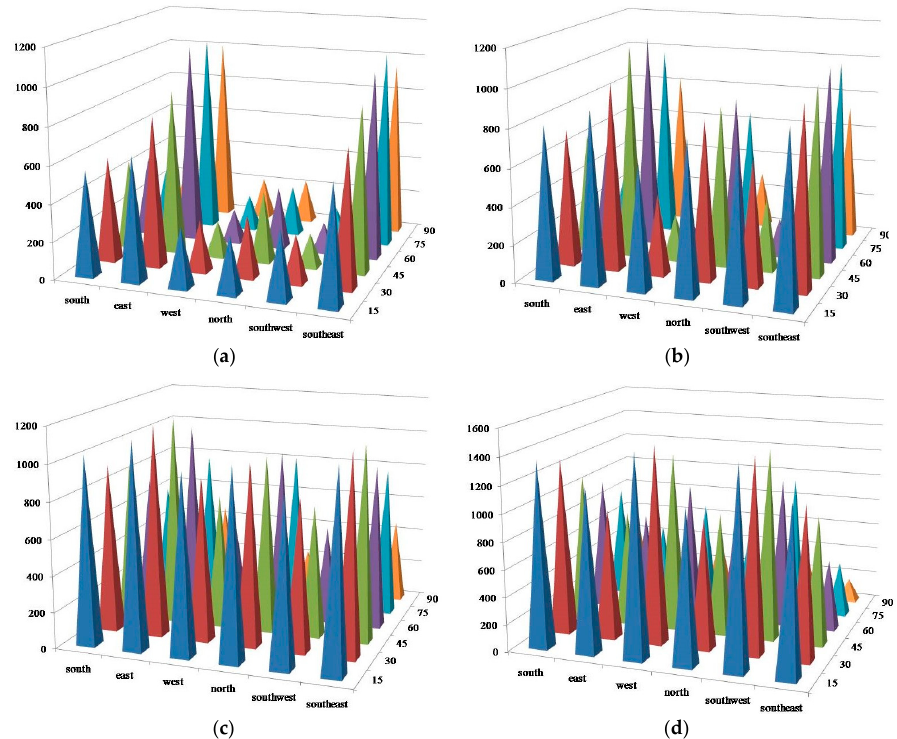
Figure 12. Measurements results of the power density of solar radiation carried out in El Hierro on 25 July, as functions of daytime and spatial orientation of the receiver (the angle to the ground and geographic direction): ( a ) 9 a.m., ( b ) 10.45 a.m., ( c ) 12.30 p.m., and ( d ), 2.15 p.m., based on the own research.